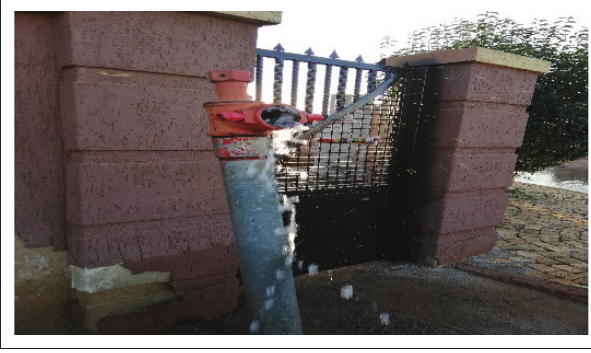
FIGURE 2: Potholes in Extension 13 in Protea Glen.